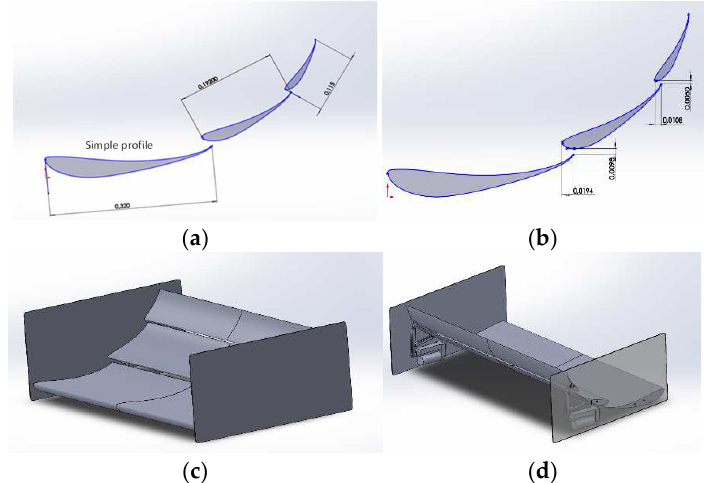
Figure 2. Case studies include: ( a ) simple profile; ( b ) multi-element profile; ( c ) 3D Wing without actuator; ( d ) 3D wing with two actuators.